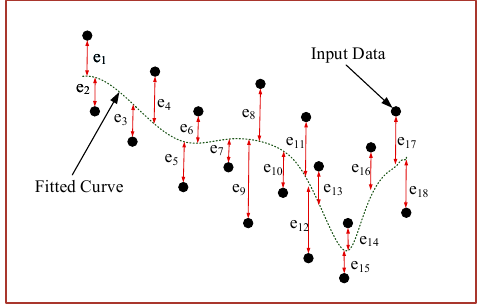
Figure 4. Curve fitting in the procedure of optimization by ANN to achieve the least square error.